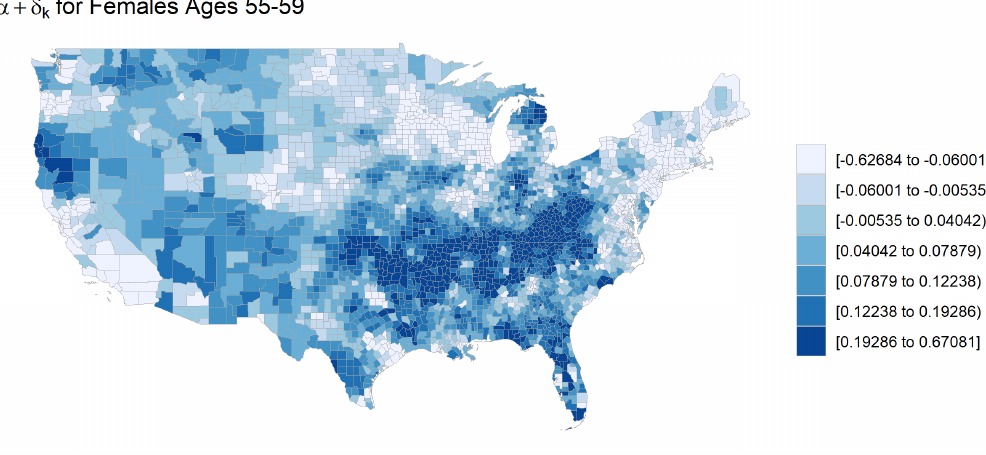
Figure 9. County-level time trends ( α + δ k ) for females ages